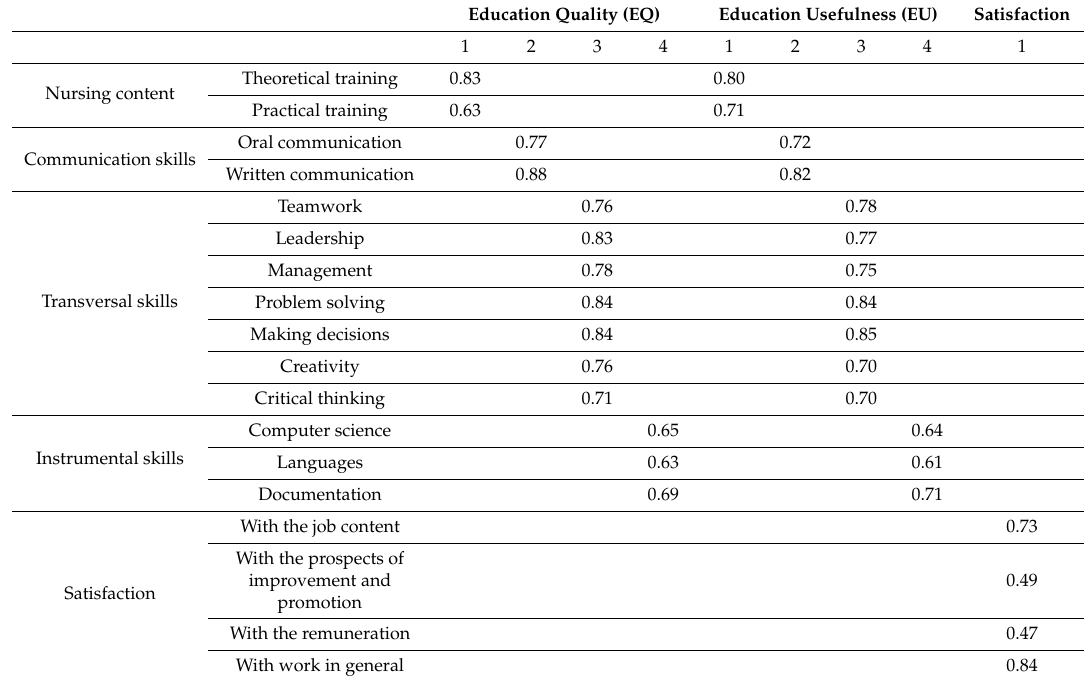
Table 2. Factor loading